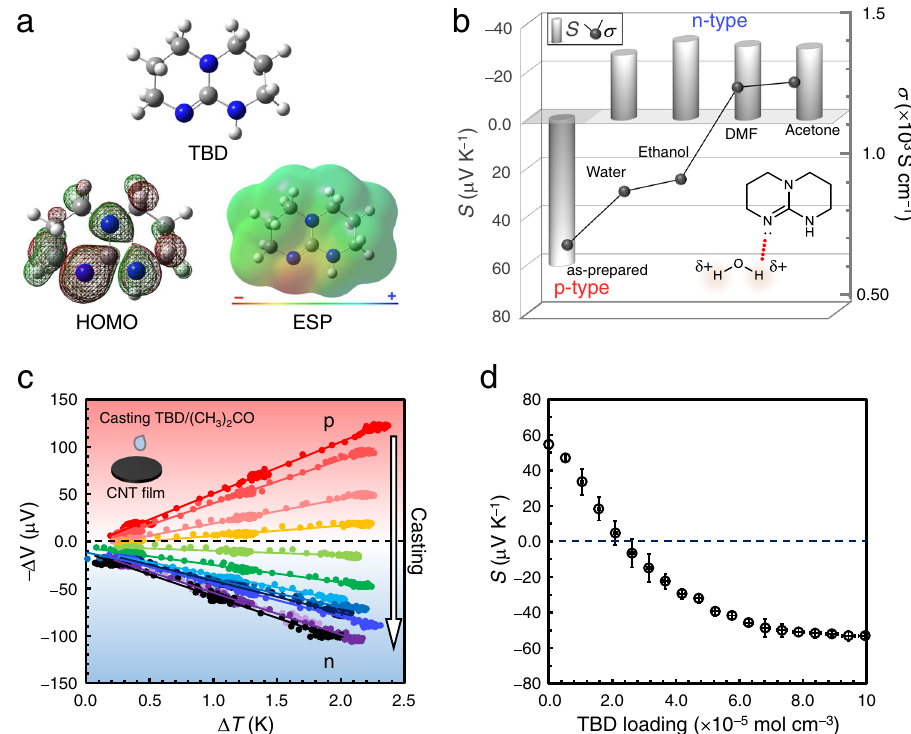
Fig. 4 Calculated electronic structure of TBD, effects of different solvents, and stepwise doping of TBD to CNT. a Molecular surface mapping of TBD from DFT (B3LYP/6-31 G) calculation. White, gray, and blue balls indicate hydrogen, carbon, and nitrogen atoms, respectively. Red and green colors indicate positive and negative phases of the orbital, respectively. ESP: electrostatic potential. Warm color indicates a more negative potential compared to the other locations. Calculation results for the other bases are shown in Supplementary Fig. 1 of SI. For all dopants, the double-bonded nitrogen atom participates in the HOMO and carries high negative charge, suggesting dominant contribution of this site towards electron transfer to CNTs. b Variation in Seebeck coef fi cient ( S ) and electrical conductivity ( σ ) of TBD-doped CNT fi lms according to the type of solvents. TBD concentration in DMF was fi xed at 71 mM (10 mg mL − 1 ). Inset: schematic interaction between lone-pair electrons of TBD and acidic hydrogen of water (a polar protic solvent). Raw data of solvent dependencies are summarized in Supplementary Table 1. c Representative plots of thermopower ( − Δ V ) vs . the supplied temperature difference ( Δ T ) for CNT fi lms doped with given amounts of TBD. Inset: schematic of the doping process, in which the TBD loading was controlled by the drop-casting of given volumes of TBD solution in acetone (0.17 g L − 1 ) on the CNT fi lm ( ϕ 17 mm, 11.6 μ m in thickness). After repeated doping, the thermopower slope fi nally displays n-type polarity. d Seebeck coef fi cient of the CNT fi lms (slope of the plots in panel c) according to the molar loading of TBD. It is estimated that S = 0 μ V K − 1 at a TBD loading of ~2.2 × 10 − 5 mol cm − 3 . Data statistics: n ≥ 3. Error bars indicate the corresponding